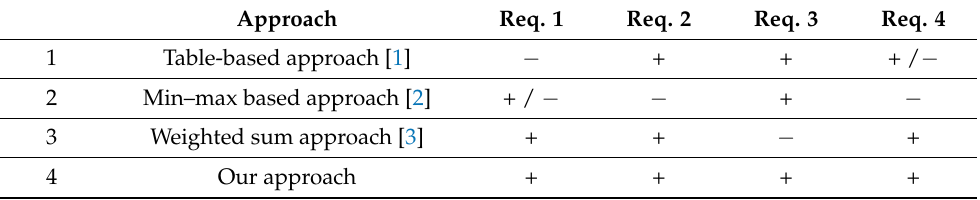
Table 1. Comparison of existing approaches to the integral metric calculation.